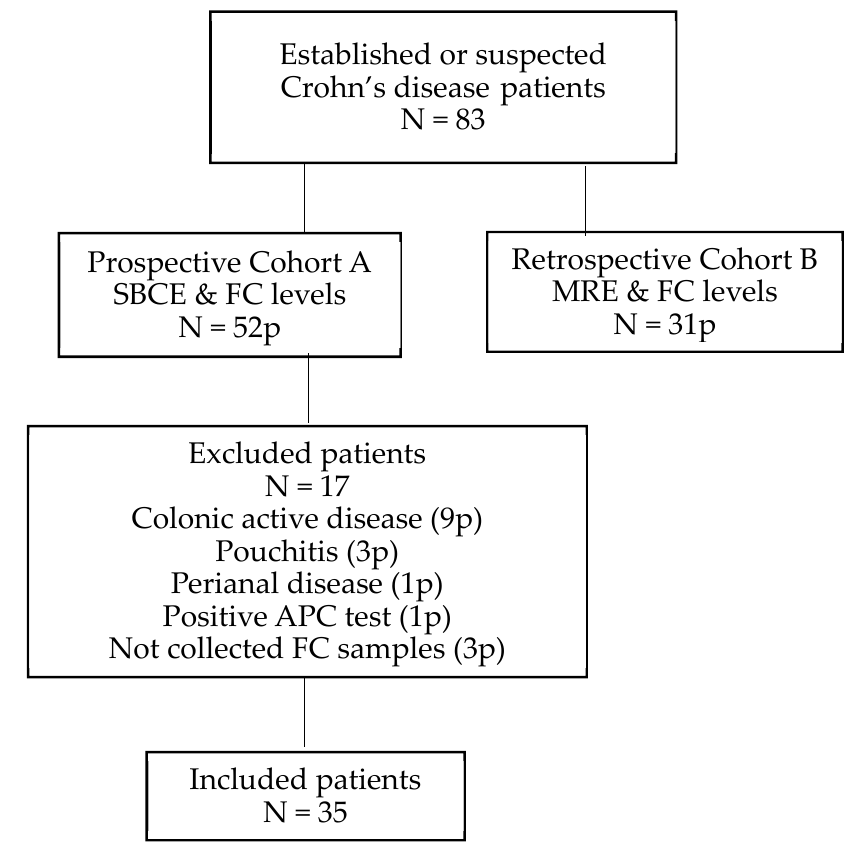
Figure 1. Study flow chart.